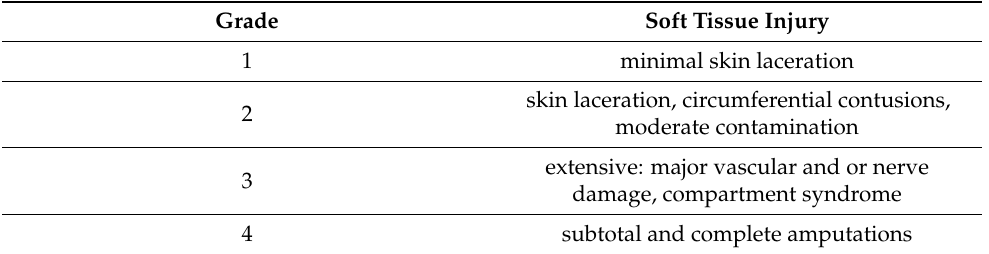
Table 3. Classification of open fractures according to Tscherne and Oestern